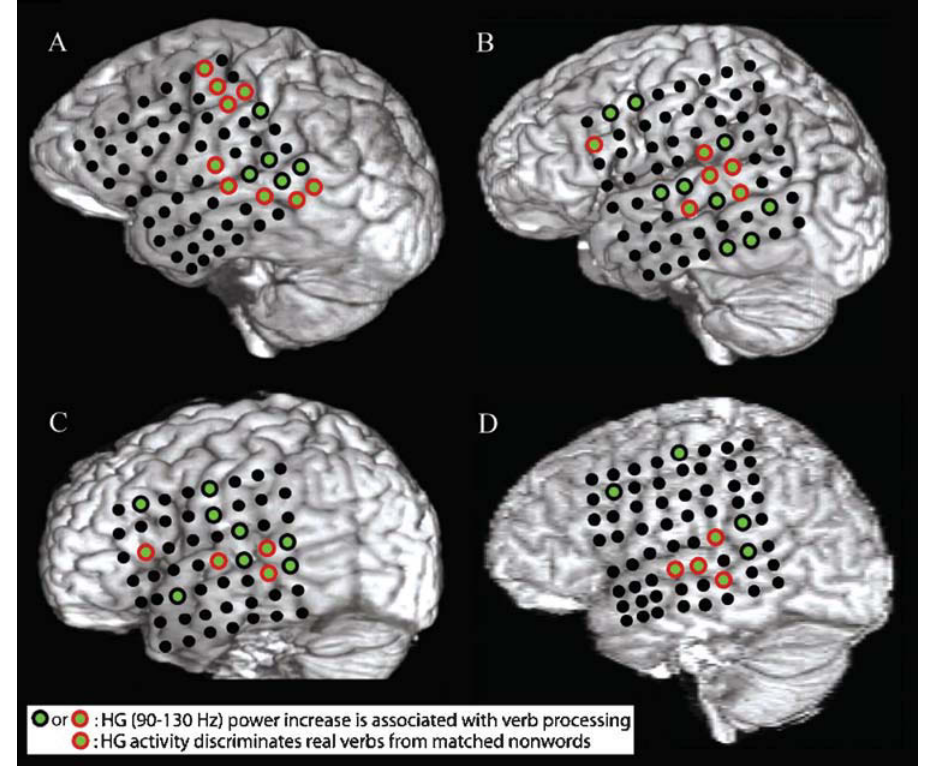
Figure 1. A–D show structural MRI renderings with electrode locations for the four subjects studied. Electrodes that exhibited a significant pre- to post-stimulus increase in HG power following verb presentation are shown with green centers. Electrodes that also showed a greater increase in HG power for presentation of verbs than for presentation of acoustically matched nonwords are outlined in red. Verb processing compared to nonword processing activates a distributed network of cortical areas including the post-STG, the mid-STG, and the STS.